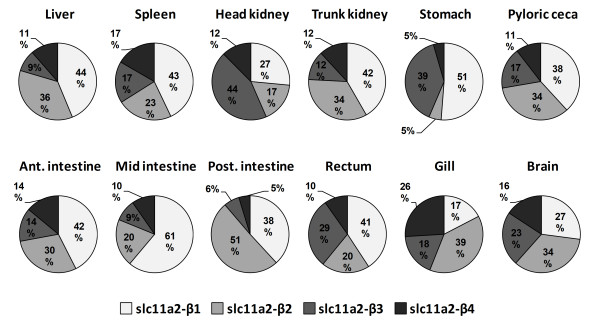
Relative constitutive expression of the four slc11a2-β isoforms. Constitutive expression of the slc11a2-β isoforms was determined in several sea bass organs, by optimized semi-quantitative PCR.